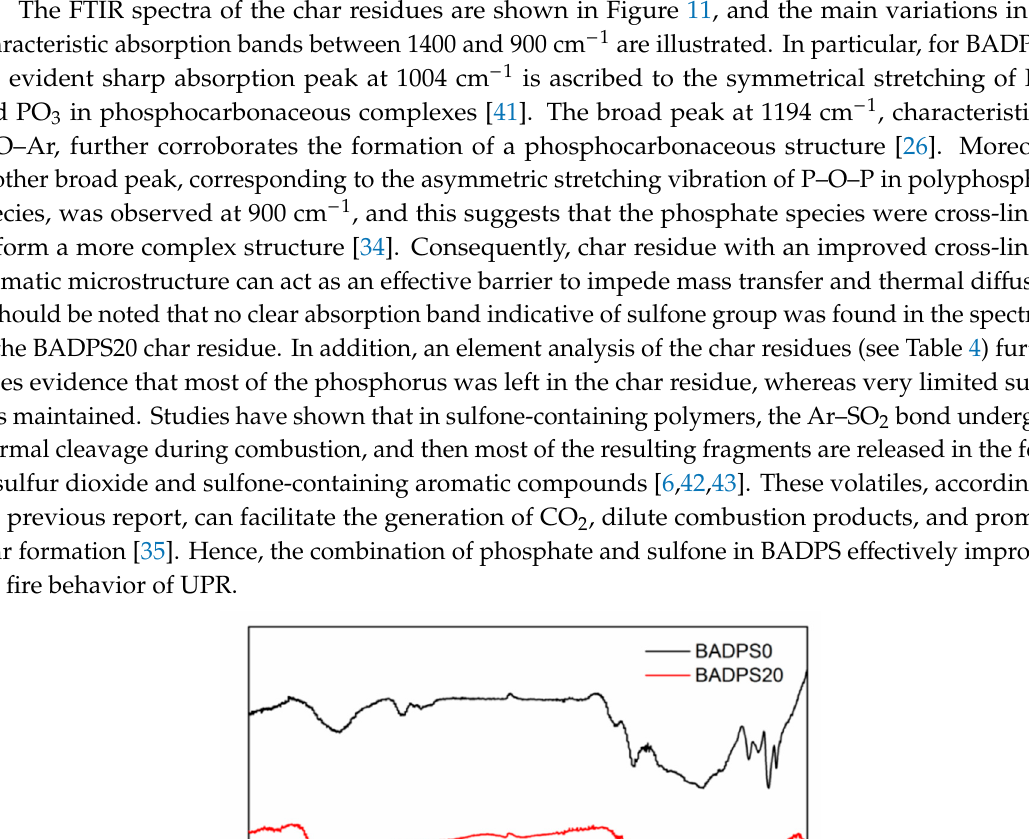
Figure 10. Raman spectra of the char residues for ( a ) BADPS0 and ( b ) BADPS20.